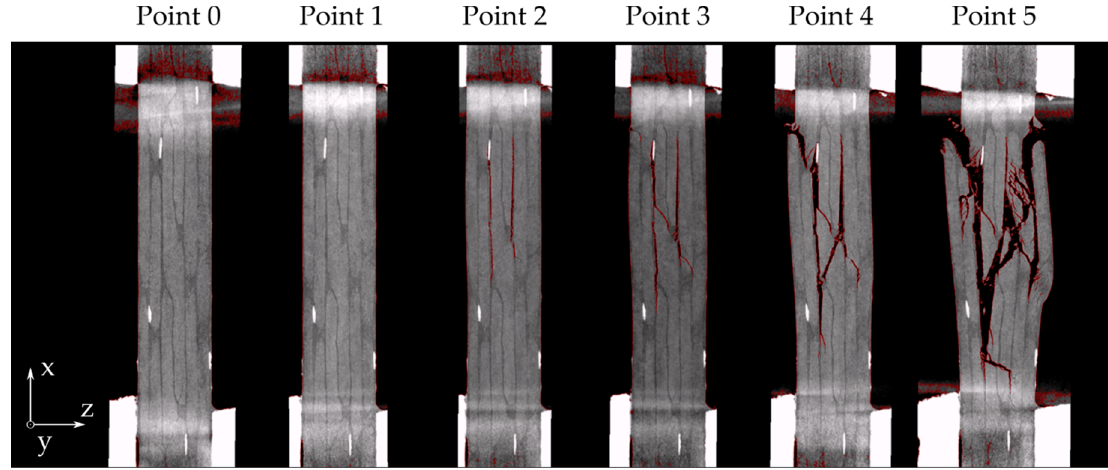
Figure 5. Side-by-side damage evolution in a 90° loaded [45, − 45,0] s laminate.